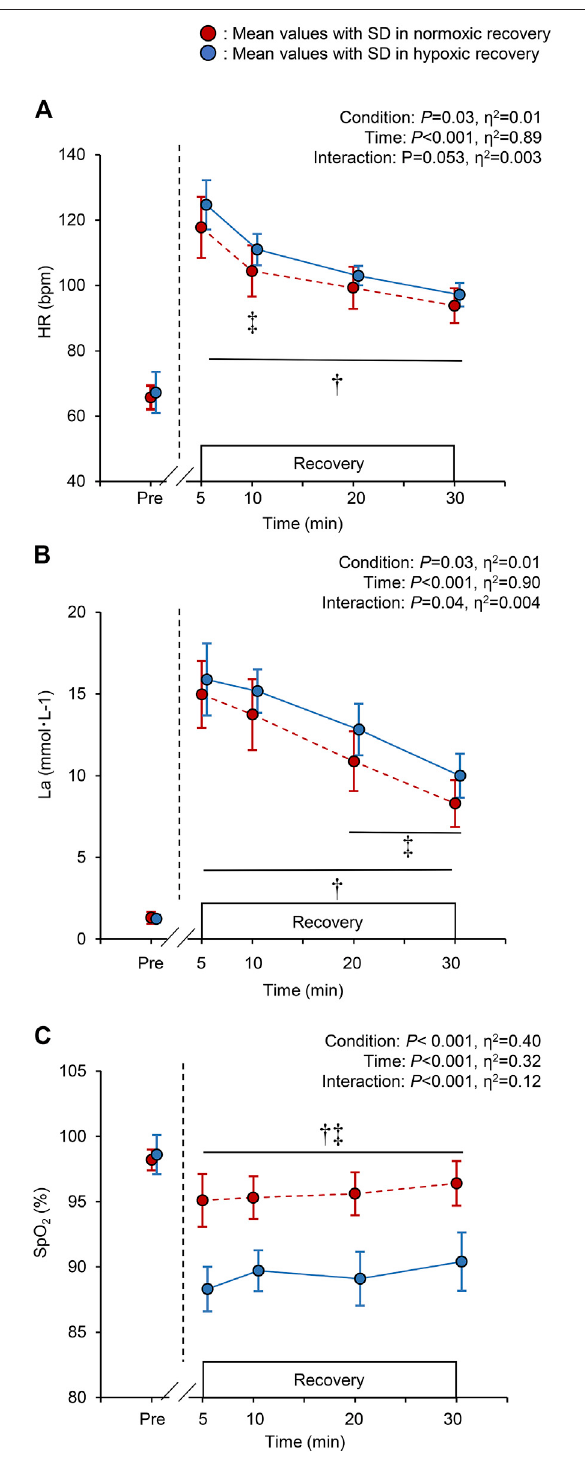
FIGURE 3 | Changes in the heart rate [HR; panel (A) ], blood lactate concentration[La;panel (B) ],andperipheralarterialoxygensaturation[SpO 2 ;panel (C) ],atbaseline(pre)andduringthe30-minrecoveryundernormoxiaandhypoxia. Allthemarkersarethesameasin Figure2 . † p < 0.05vs.pre-valuesinboth the normoxic and hypoxic recovery conditions, ‡ p < 0.05 between normoxic and hypoxic recovery conditions at the indicated time point.